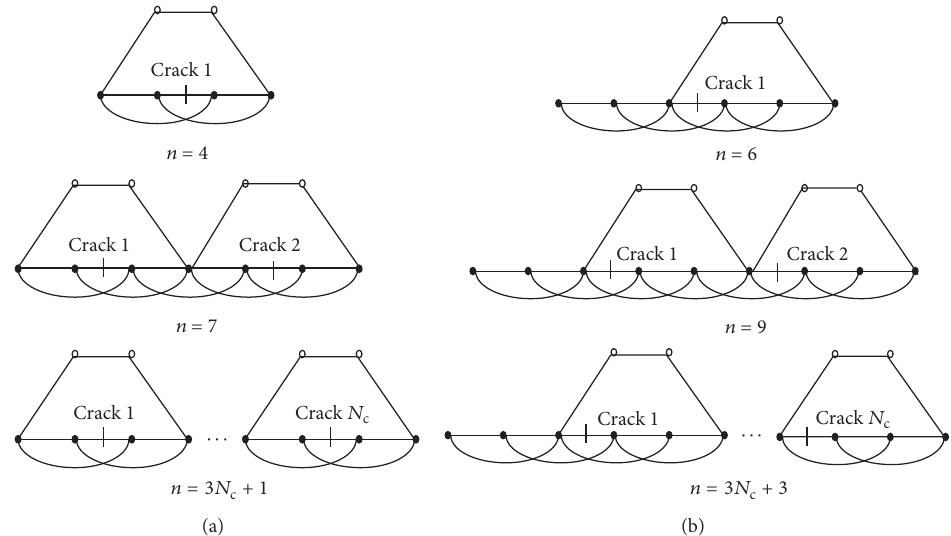
Figure 17: Determination of the minimal number of sensors. (a) Localization using GSM by linear gapped interpolation. (b) Localization using